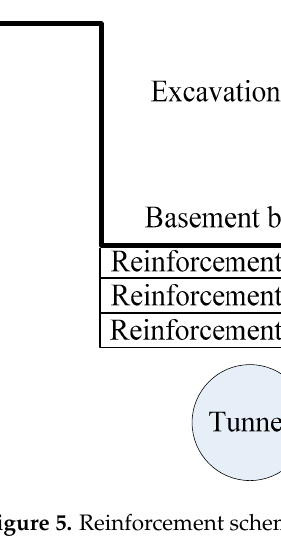
Figure 5. Reinforcement scheme for basement bottom.